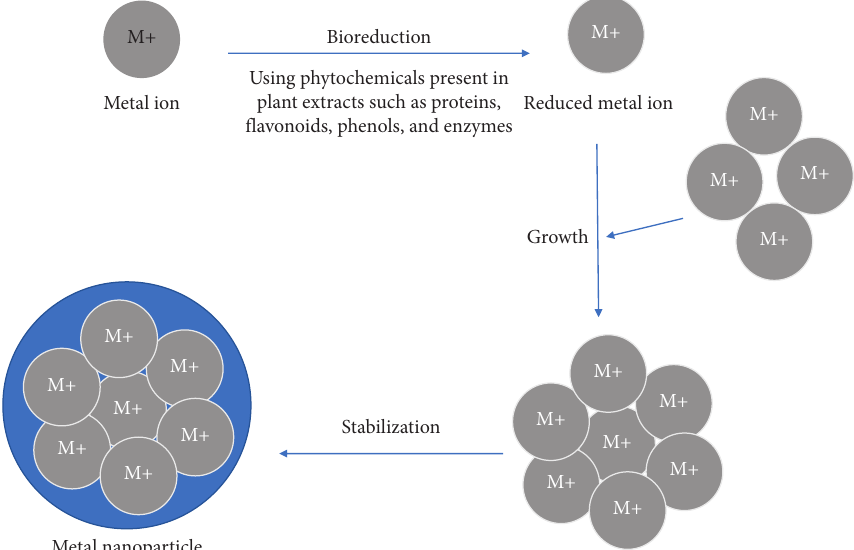
Figure 3: Mechanism of AgNPs green synthesis.